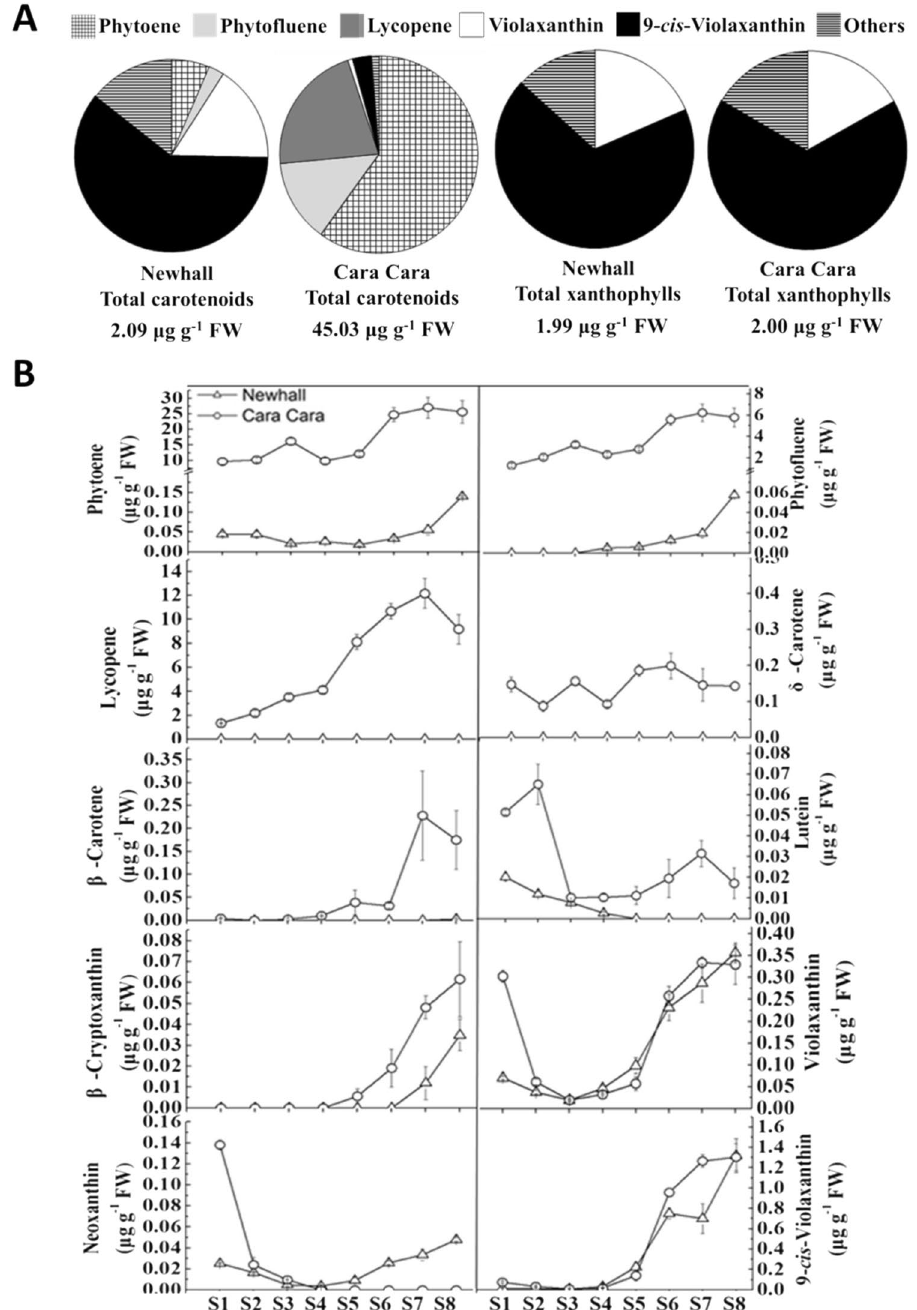
Figure 2. Profiles of carotenoids in Newhall and Cara Cara oranges. ( A ) Composition and amount of total carotenoids or total xanthophylls in flesh of Newhall and Cara Cara ripe fruit. ( B ) Changes in content of carotenoids in flesh of Newhall and Cara Cara oranges during fruit development and ripening. The bars represent SE from three biological